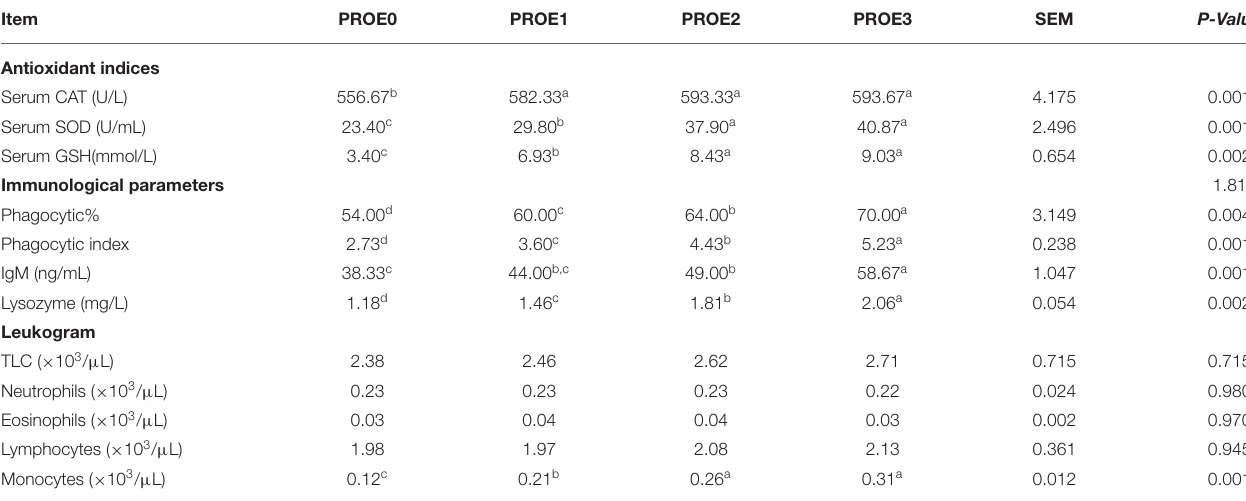
TABLE 6 | The effect of PROE supplementation on the antioxidant activity, selective immunological parameters, and Leukogram of broiler chickens. Item